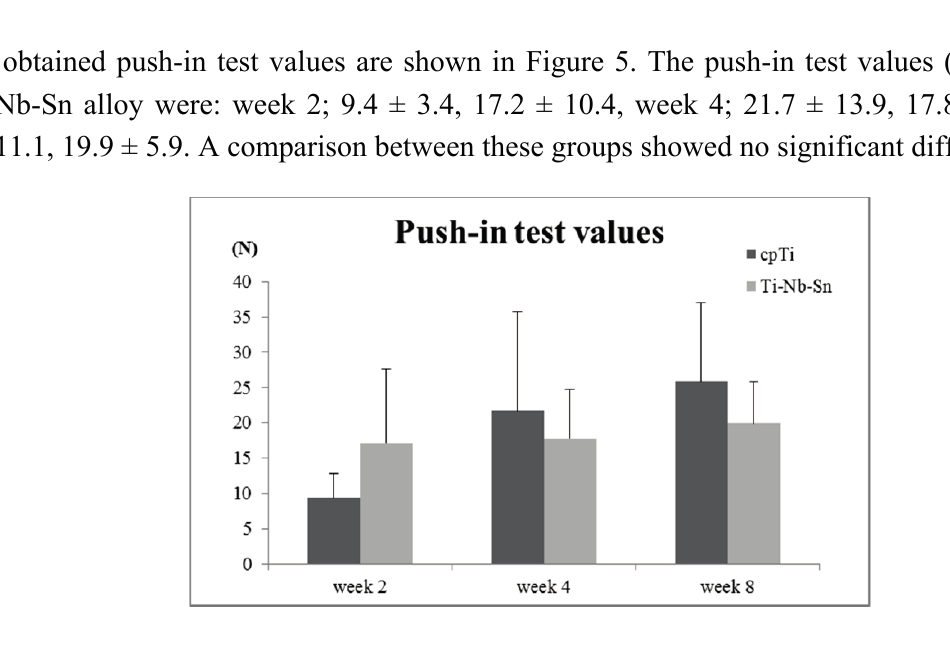
Figure 5. Push-in test values for cpTi and Ti-Nb-Sn alloy. Data are the mean ± SD ( n =